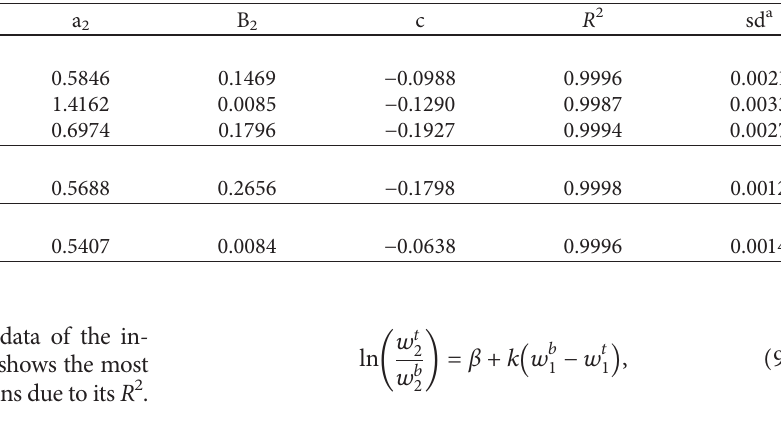
Table 4: Parameters of equation (6) for the mixture of polyethylene glycol/isopropyl alcohol +ethanol +salt (Na ATPSs at different temperatures. T (K) a b c d R 2 sd a Polyethylene glycol +ethanol +Na 2 SO 4 308.15 Isopropyl alcohol +ethanol+ Na 2 SO 4 308.15 − 0.2676